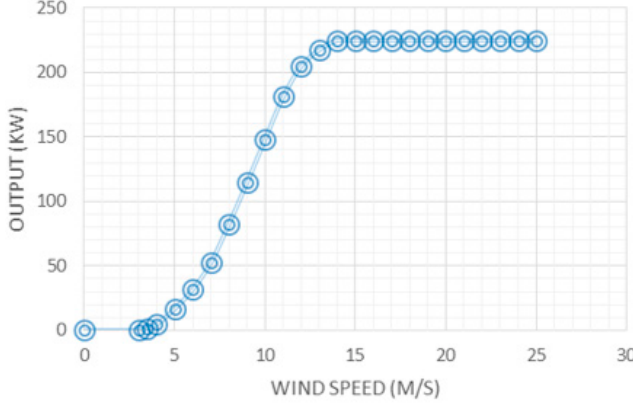
Figure 4. Power curve of the V-27.